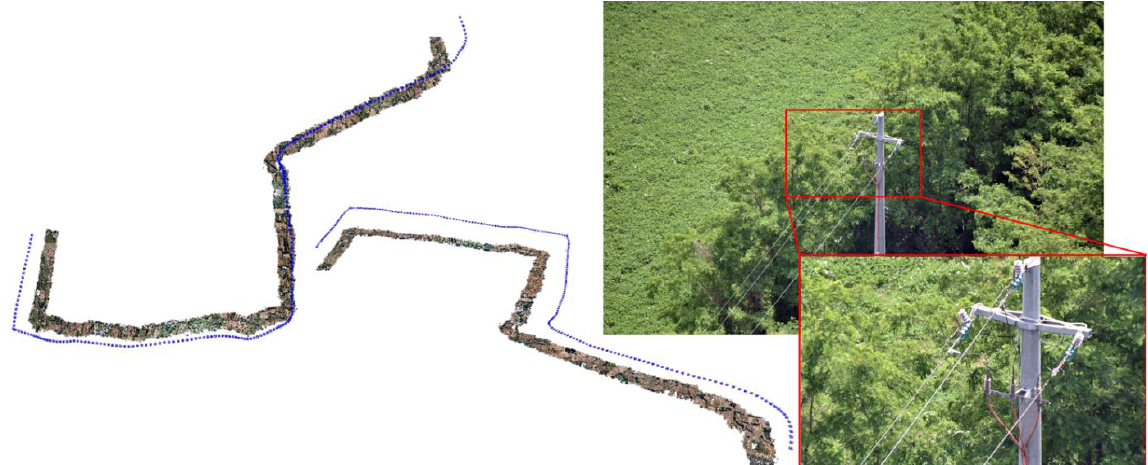
Figure 3. Examples of two helicopter-based camera networks with the recovered camera poses (blue pyramids) over the sparse point cloud (left and centre), and forward-looking image acquired over a LT power line (right).  good coverage of the corridor (ca. 30 m width by each side of the transmission line), to detect any potential interference between power line and non-power line